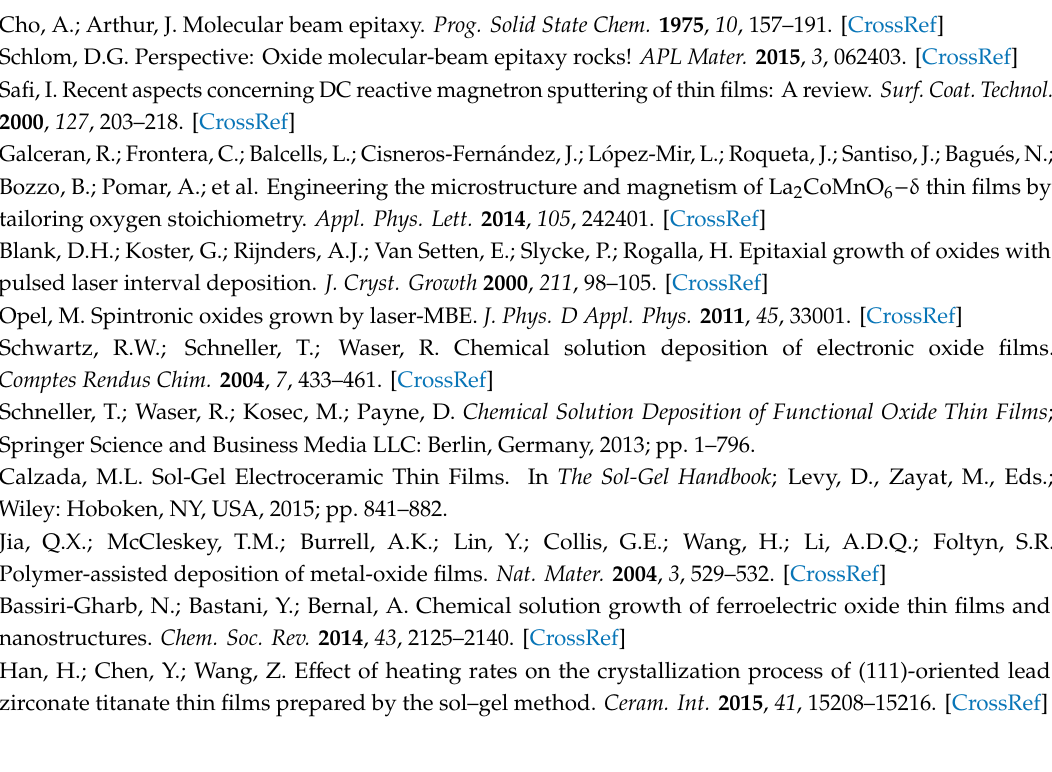
Figure S1: High-resolution θ / 2 θ x-ray di ff raction (XRD) scans of the (0 0 2) reflections comparing thin films grown by conventional thermal annealing (CTA) and rapid thermal annealing (RTA). Figure S2: Rocking curves of the (0 · 0 · 2) reflections of La 2 NiMnO 6 / SrTiO3 thin film, and (b) La 2 NiMnO 6 / LaAlO 3 thin film. Figure S3: Zero-field-cooled (ZFC) and field-cooled (FC) magnetization curves measured at fields of 100 Oe and 1 kOe for two La 2 NiMnO 6 epitaxial thin film samples, grown by rapid thermal annealing (RTA). Figure S4: Zero-field-cooled (ZFC) and field-cooled (FC) magnetization curves measured at fields of 100 Oe and 1 kOe for two La 2 NiMnO 6 epitaxial thin film samples, grown by conventional thermal annealing